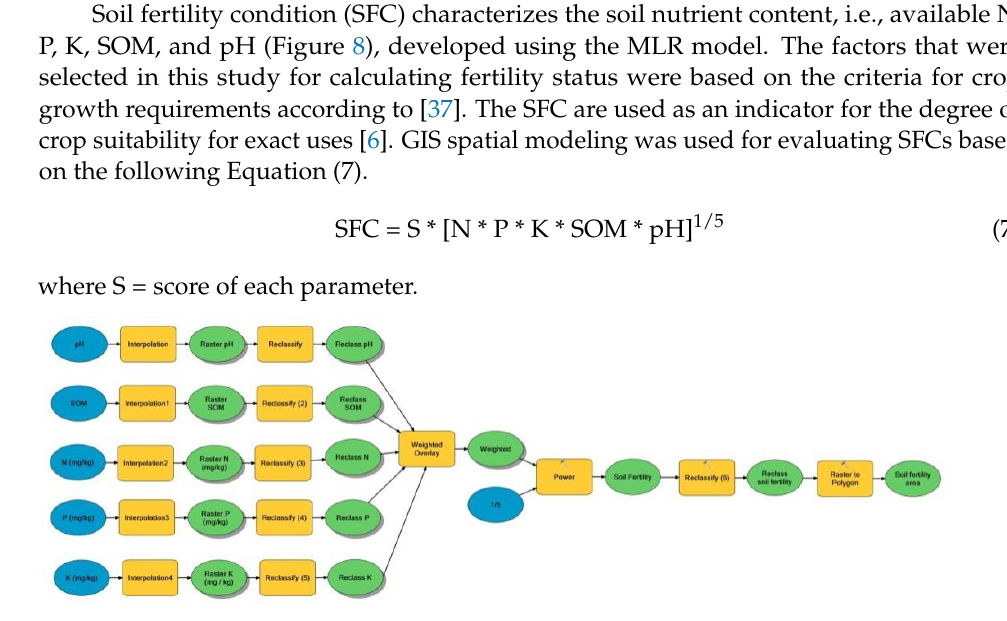
Figure 8. Flow chart devised in this study to model SFC.